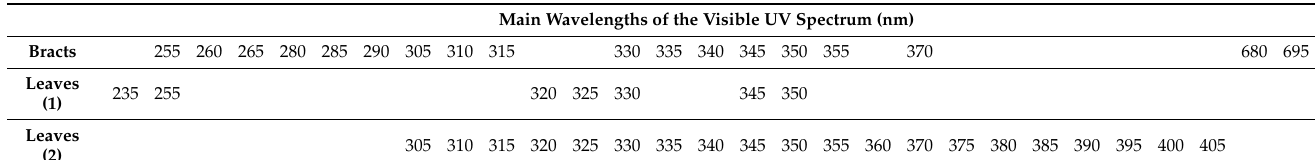
Table 8. Visible UV spectrophotometric